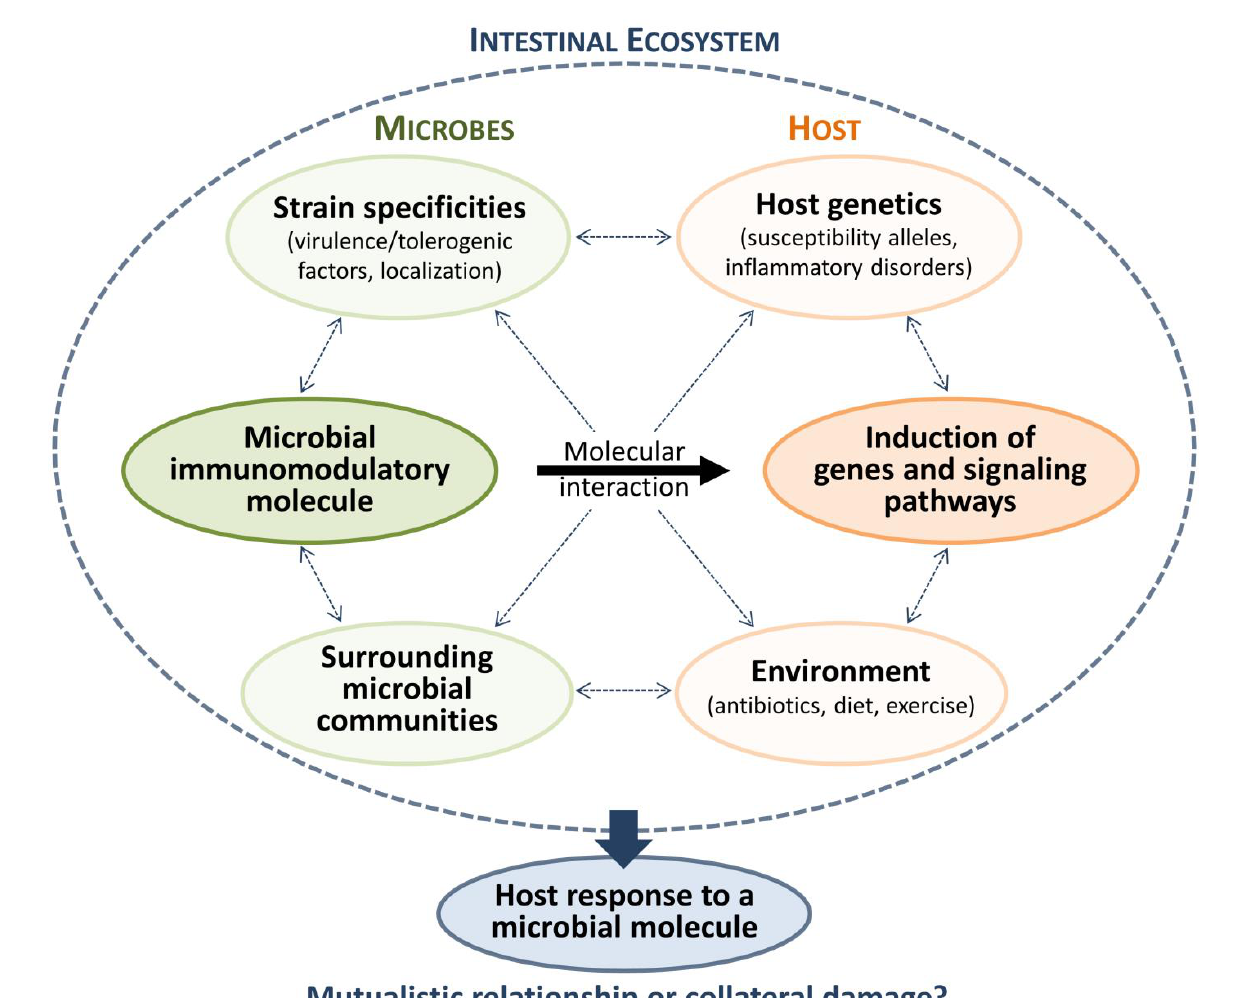
FIGURE 1: Flow chart representing host, microbe and environmental factors that influence the host response to a microbial immunomodu- latory molecule. These complex interactions determine whether a specific host-microbe interaction contributes to mutualism or leads to col- lateral damage in the long